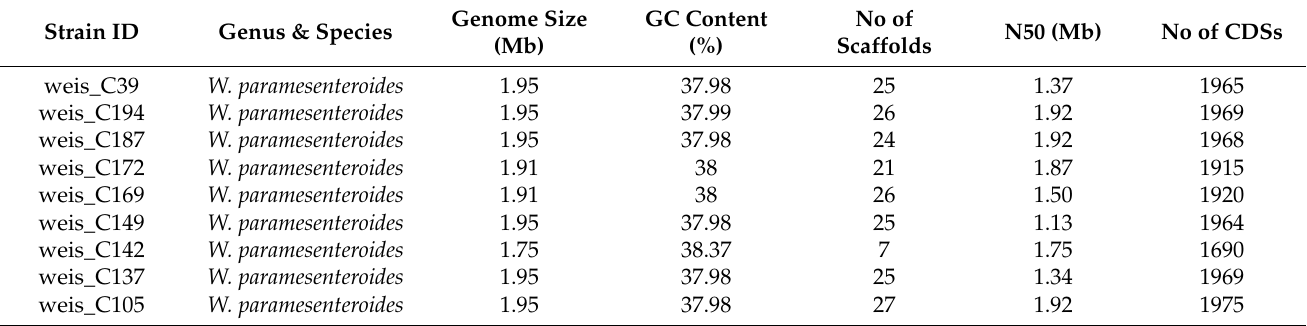
Table 1. Species identification and assembly statistics for the nine W. paramesenteroides isolates.